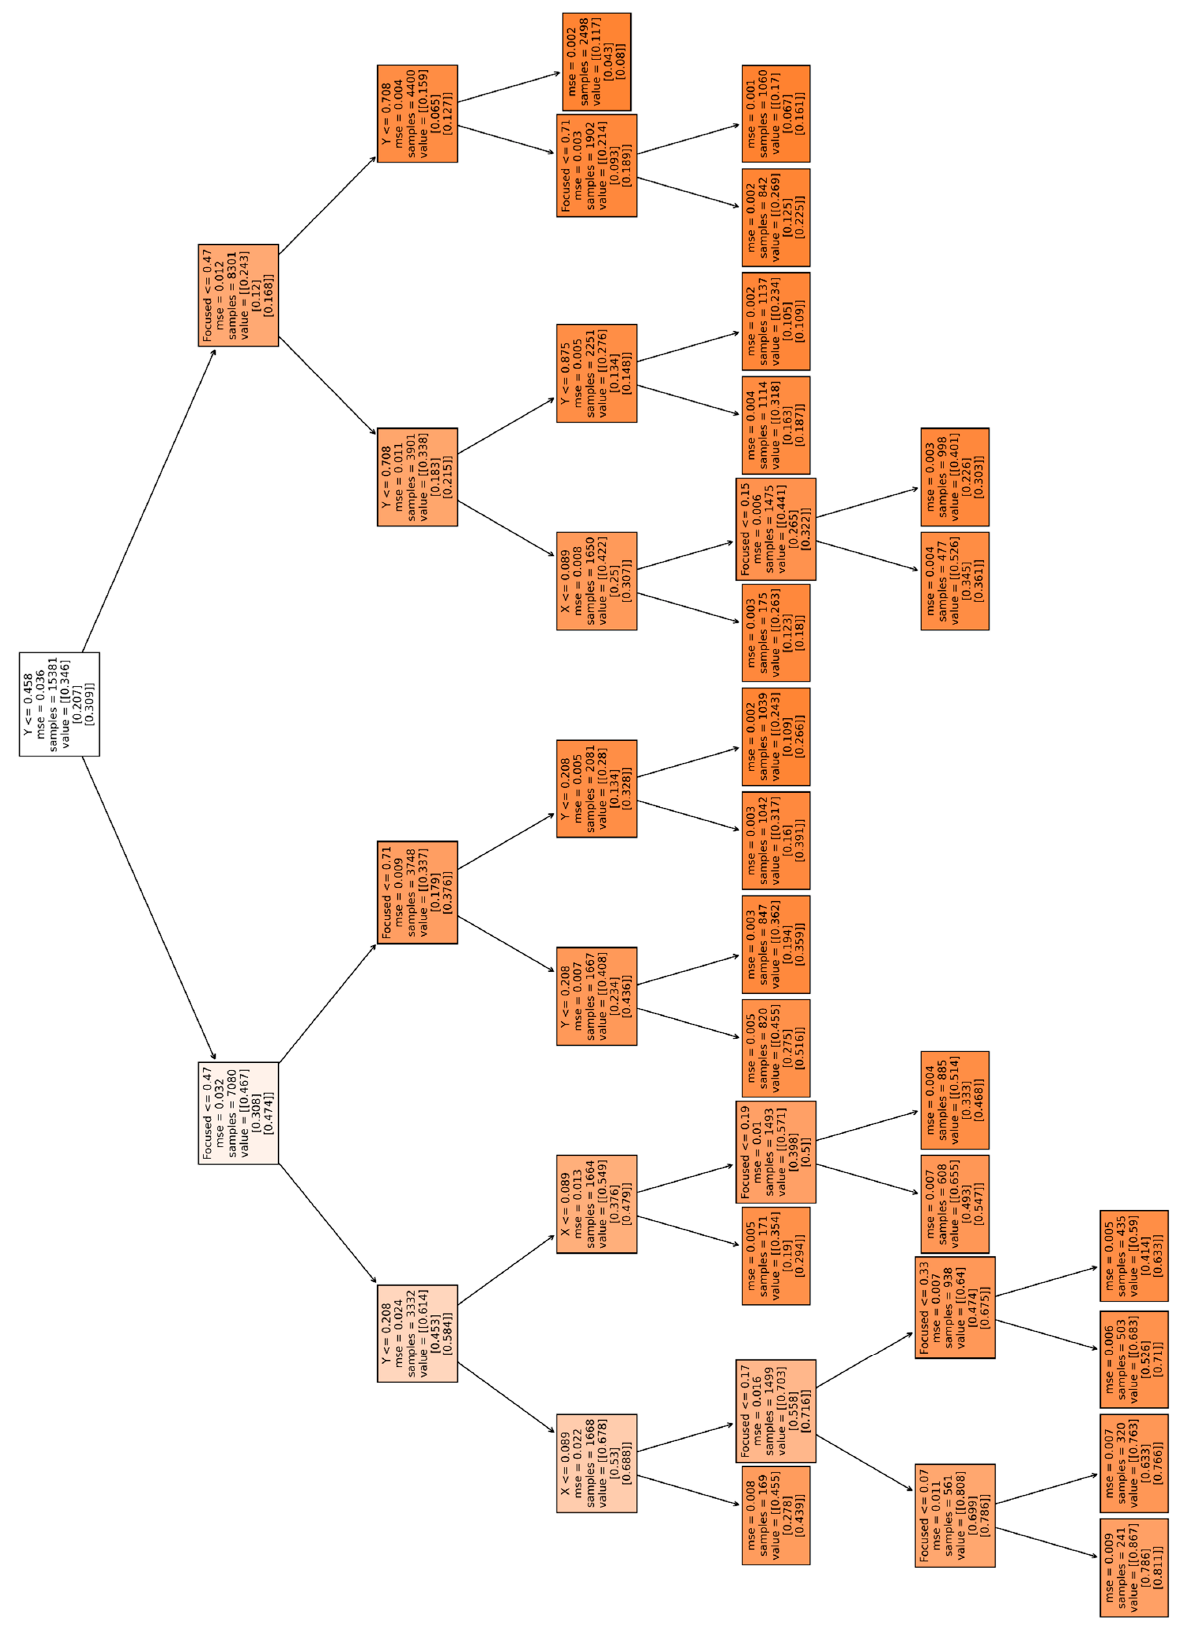
Figure A1. Decision tree for predicting maximum pressure, power, and temperature at the focused zone.